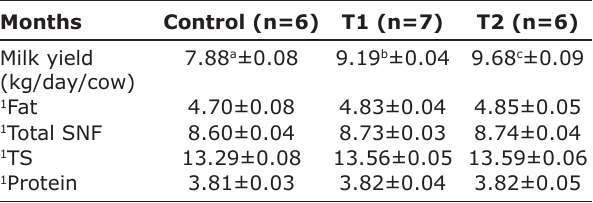
Means bearing different superscript differ significantly (p<0.01) column wise. 1 (%/day/animal); Total SNF=Total solid not fat, TS=Total solids, n=Number of animals in each group